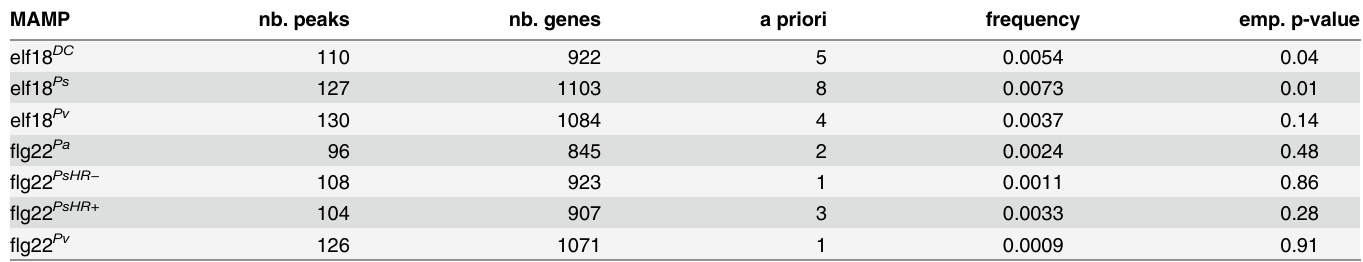
Table 2. The traits elf18 DC - and elf18 Ps -induced SGI map a significant number of a priori candidate genes. We assembled a list of 77 genes that have published evidence to alter SGI in response to either elf18 or flg22. The measure ‘ frequency ’ indicates how many a priori candidate genes were found among the number of GWA candidate genes (nb. genes) for all peaks of each trait. The empirical p -value is generated by shifting the number of peaks along the genetic positions and calculating the frequency of found a priori genes in the number of genes under these shifted peaks. The random shift along the genetic position maintains patterns of linkage disequilibrium and was repeated 100 times.